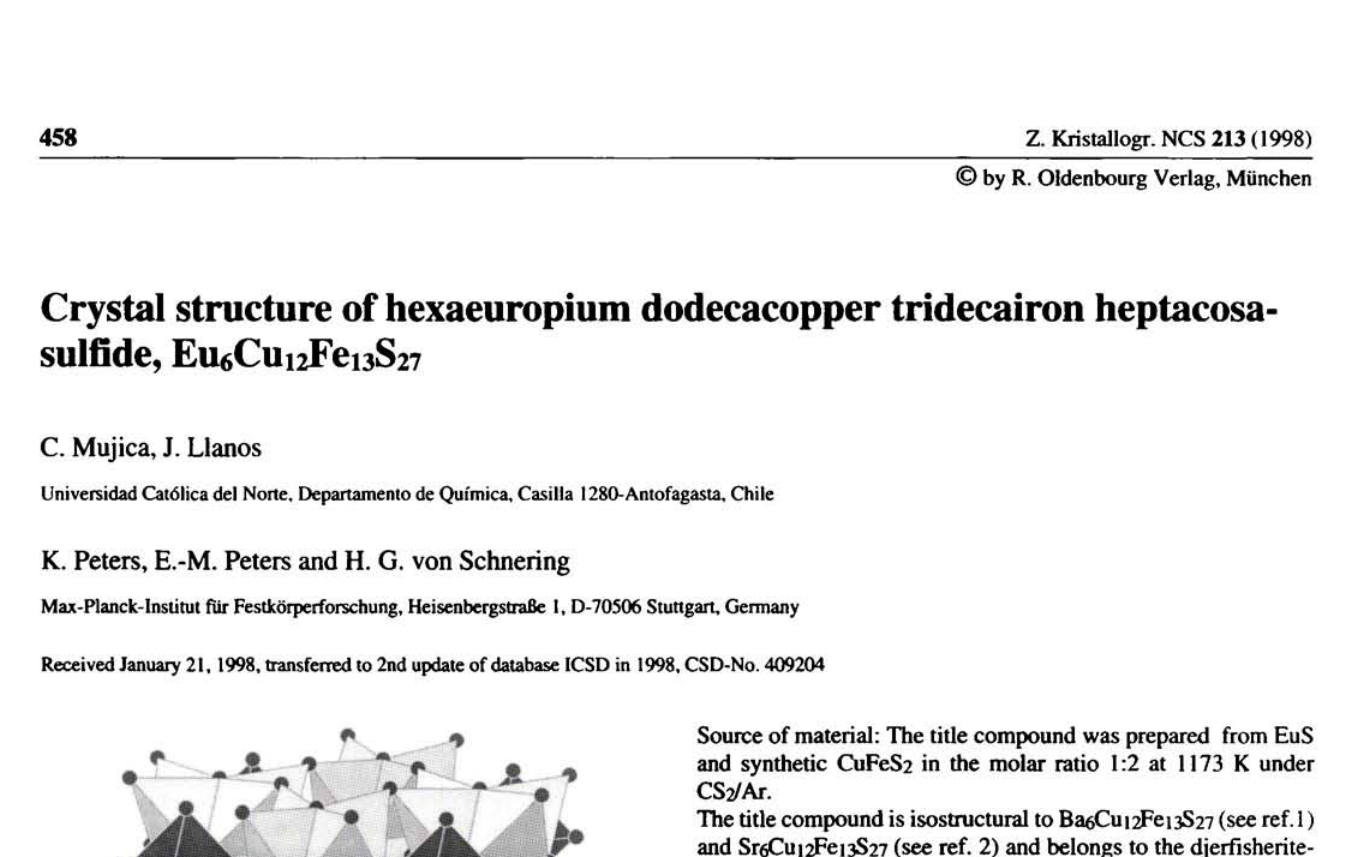
Table 1. Parameters used for the X-ray data collection Crystal: